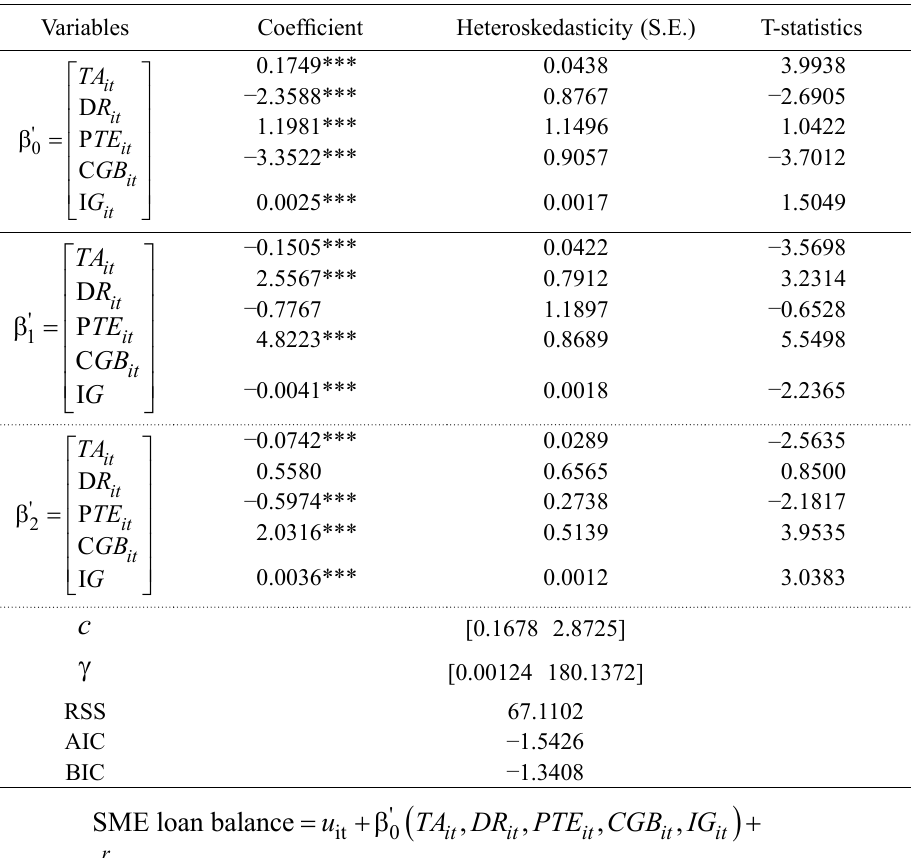
Table 10. Estimation results of the two-threshold PSTR model for small to medium-sized